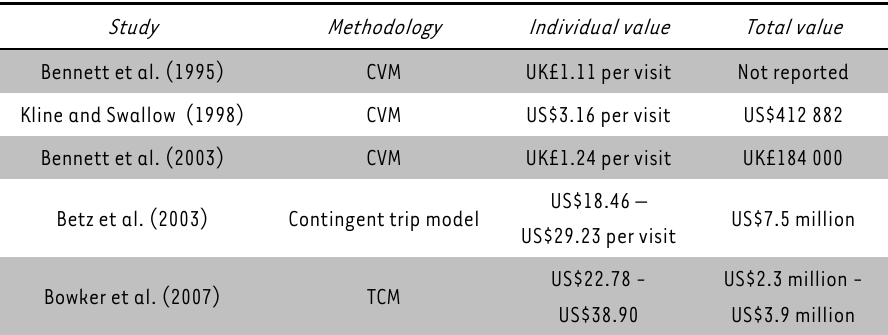
TABLE 1: Summary of international studies’ results Study Methodology Individual